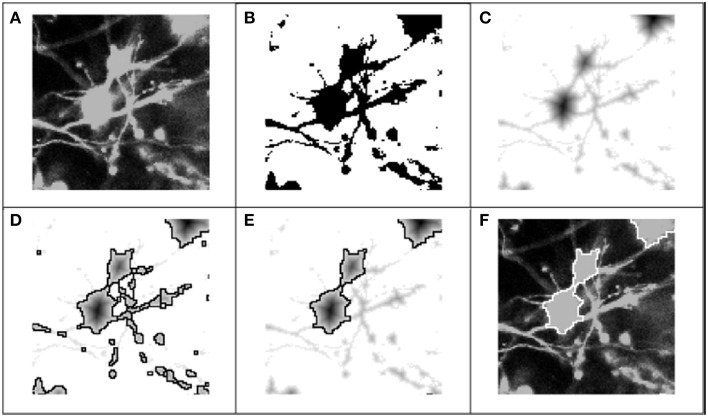
Process flow for 2-D segmentation of cell bodies. Graphic representation of 2-D segmentation process: (A) The color component for the fluorescent dye of interest was extracted to form an achromatic intensity image; (B) A global threshold was applied for each 2-D frame in the z-stack, separating pixels into foreground (regions of interest) and background; (C) The regional minima were defined by applying the Euclidean distance transform (or alternatively the Chebyshev transform) to the “thresholded” image; (D) Following application of the distance transform, the watershed algorithm was applied to the transformed image: the mottled contours of the neurites produced very fractured segmentation boundaries, while the rounder, smoother morphologies of the soma produced accurate segmentation boundaries; (E) Objects were classified as either soma or neurite fragments according the area enclosed by the watershed lines, and neurite fragments were removed from consideration. (F) Picture of the cell body boundaries projected back onto the original image.